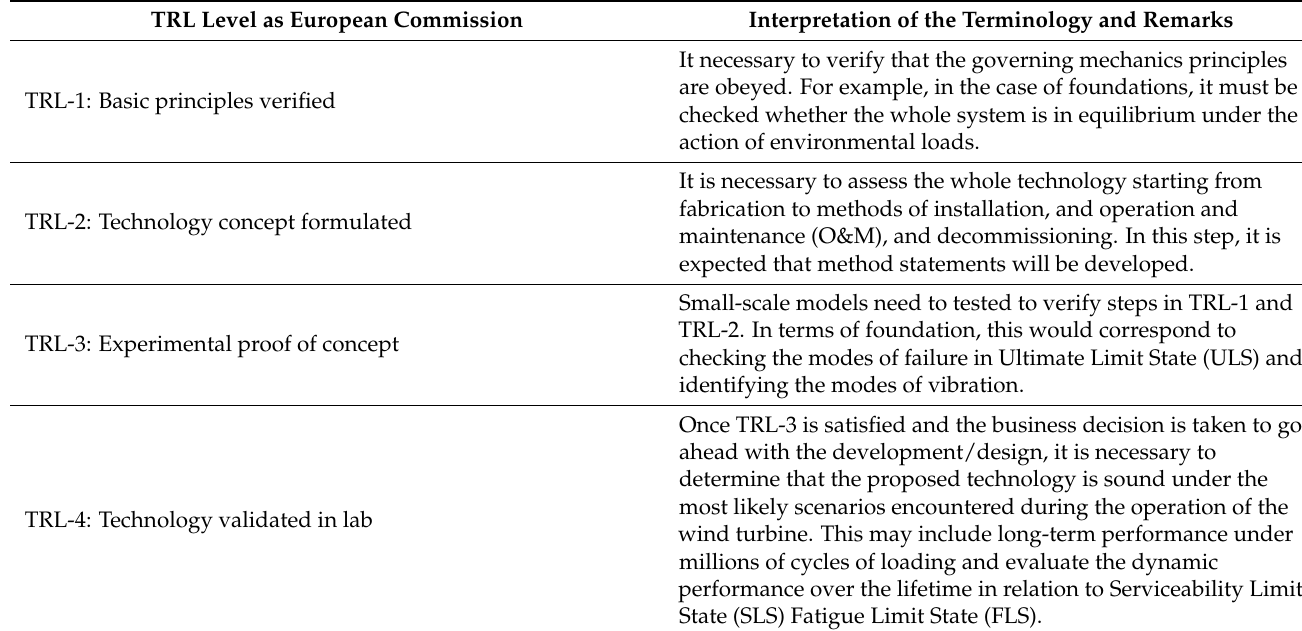
Table 1. Technology Readiness Level